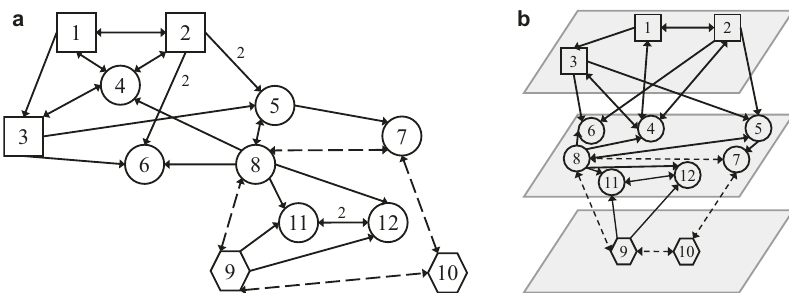
Fig. 1 Directed multilayer network. a Directed network with N = 12 nodes of M = 3 shape-coded different kinds and links of L = 2 different kinds, represented by either solid or dashed arrows. The vertex set is V ¼ f 1 ; ¼ ; 12 g , the arrow sets are E 1 ¼ fð 1 ; 2 Þ ; ð 1 ; 3 Þ ; ð 1 ; 4 Þ ; ð 2 ; 1 Þ ; ð 2 ; 4 Þ ; ð 2 ; 5 Þ ; ð 2 ; 6 Þ ; ¼ g (solid arrows) and E 2 ¼ fð 7 ; 8 Þ ; ð 7 ; 10 Þ ; ð 8 ; 7 Þ ; ð 8 ; 9 Þ ; ¼ g (dashed arrows). All weights in the sets W 1 and W 2 are equal to 1 except for the edges (2,5), (2,6), (11,12), and (12,11) (all belonging to E 1 ) that have weight equal to 2. b The three layers for the network in ( a ): top layer with square nodes, middle layer with circle nodes, and bottom layer with hexagon nodes. Examples of intralayer connections: 1 → 2 (top layer), 8 ↔ 5 (middle layer), 9 ↔ 10 (bottom layer). Examples of interlayer connections: 2 → 5 (between top and middle layers), 8 ↔ 9 (between middle and each individual node can be of one out of M different types (with M ≤ N ): f i ( x ) = f j ( x ) if i and j are of the same type, f i ( x ) ≠ f j ( x )